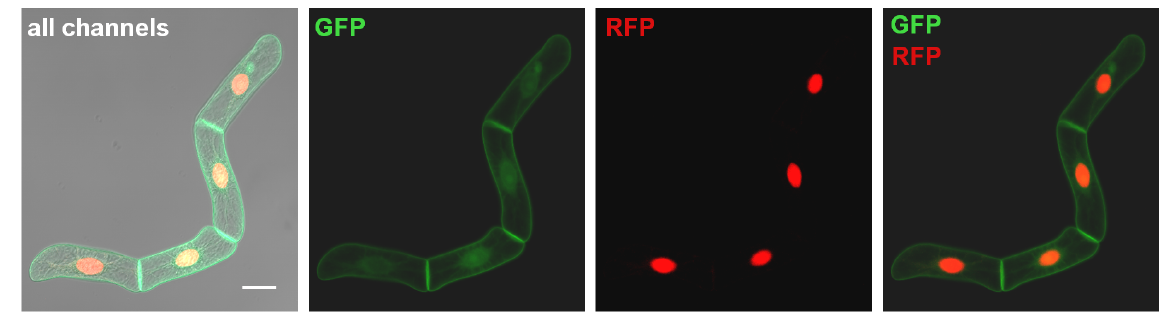
Figure 5. Double-transformed BY-2 cell line (N-20) showing different intracellular localization of fluorescent fusion proteins (after induction). All channels: Four BY-2 cells (ideally) growing in a tetrade with red and green fluorescence induced at the same time (+ differential interference contrast, DIC). GFP: the GFP-BD-CVIL fusion protein is visualized after induction with 10 µM Dex and is mainly localized to the PM and cytosol. RFP: The monomeric RFP fused to the C-terminus of the SV40 NLS is visualized after induction with 5 µM estradiol and is predominantly found in the nuclear compartment. GFP/RFP: Overlay of the GFP and RFP channels. Induction time with both elicitors was 15 h. Images were acquired using a LSM510 confocal laser scanning microscope equipped with an inverted Carl Zeiss axiovert 100 M microscope. Dual color imaging was performed using dual excitation/emission scanning in the multitracking mode (Carl Zeiss Laser Scanning Microscope software). White bar represents 20